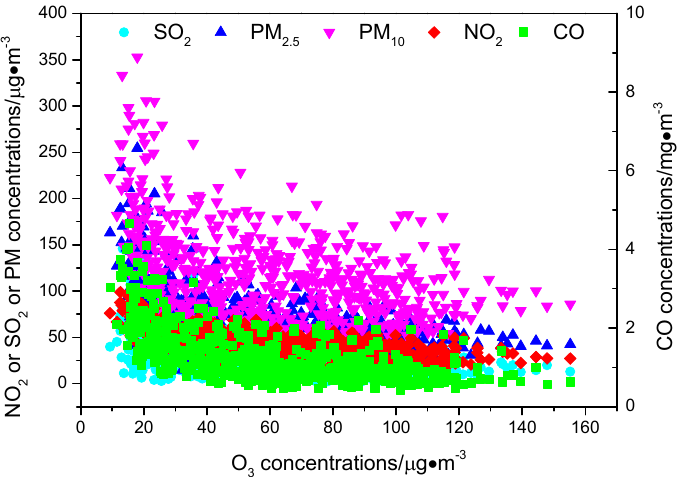
Figure 8. Scatter plot of O 3 and other air pollutants.